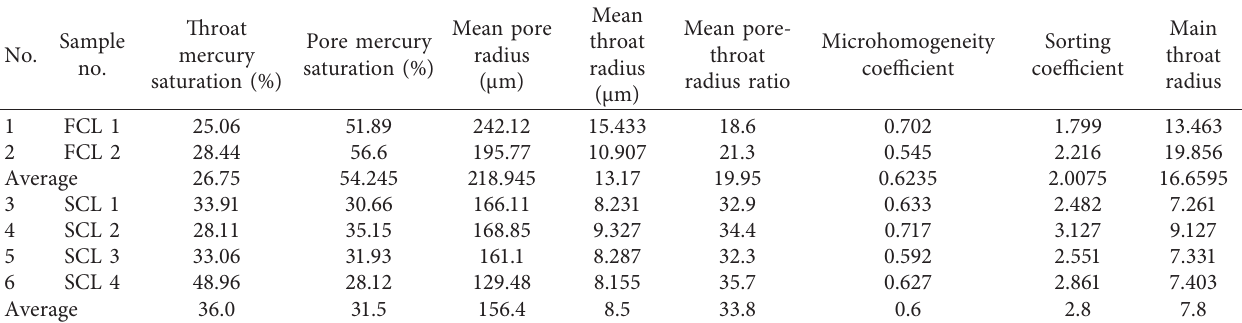
Figure 3: The polarized light micrograph of reservoir core [77]: (a) FCL; (b) SCL. Table 3: Pore structure parameter of FCL and SCL in Daqing Oilfield [72]].